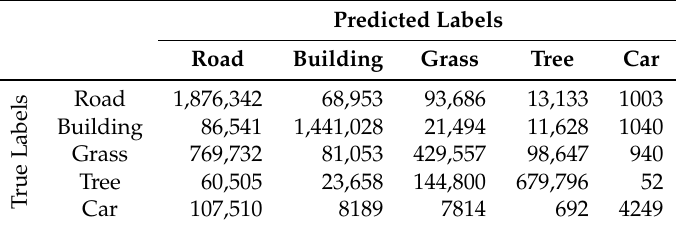
Table 5. Confusion matrix obtained for post-classification fusion (Figure 9a).